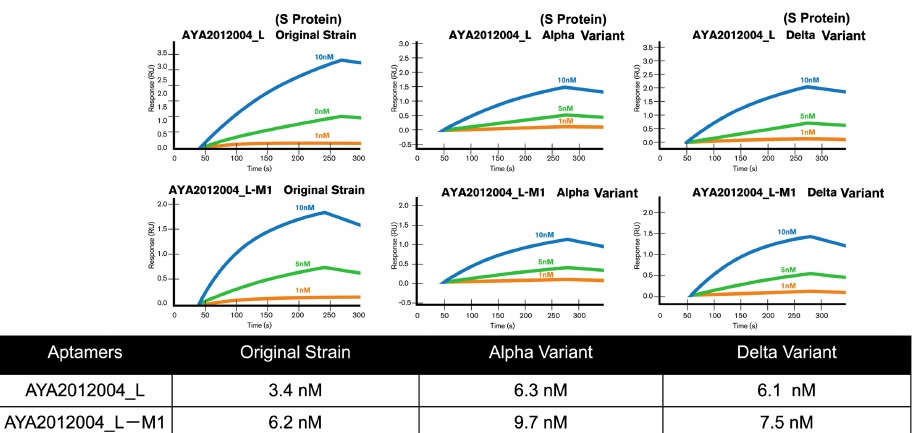
Figure 7. Binding and specificity determination of modified aptamers to different variants of S protein with surface plasmon resonance (SPR). Characterization of the binding affinity between selected aptamers and SARS-CoV-2 trimer S protein Wuhan orginal strain, Alpha, and Delta variants with surface plasmon resonance (SPR). The affinity of selected aptamers were determined via SPR. Kd values are presented in the